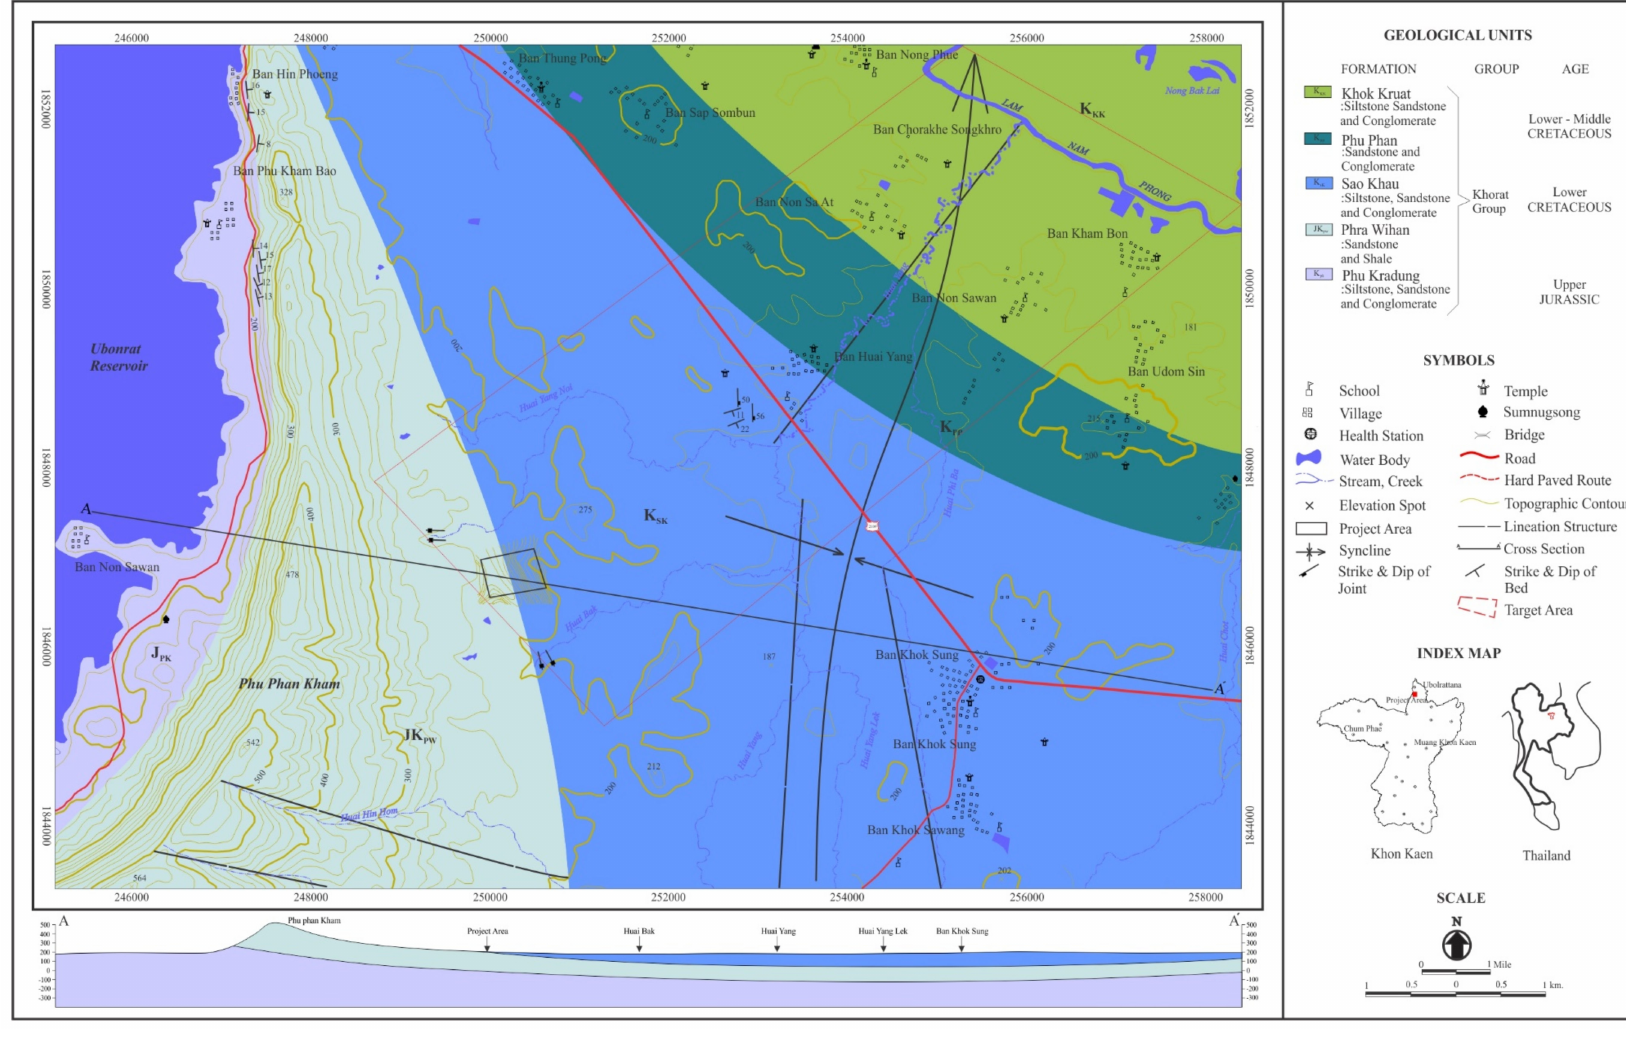
Figure 5. Geological map of the study area and adjacent